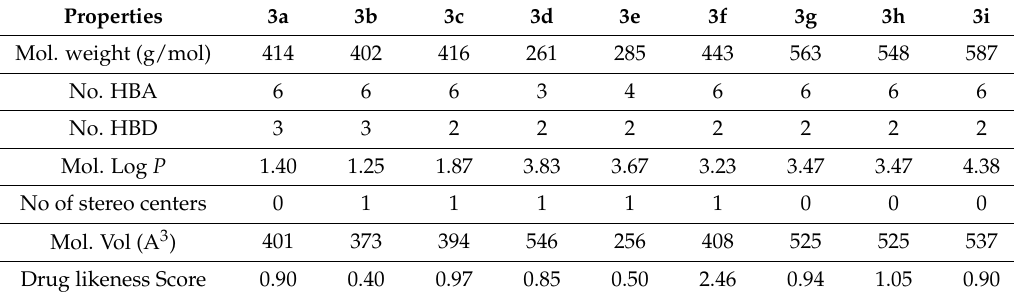
Table 3. Biological properties of synthesized compounds.